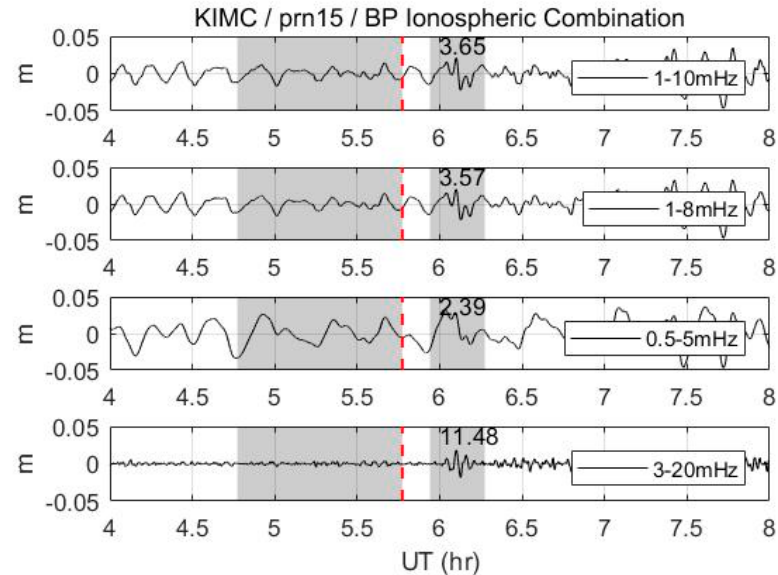
Figure 8. Band-passed ionospheric combination by different passbands (KIMC, prn15). Values in the right shade indicate the SNR. Refer to Figure 2 for notation.